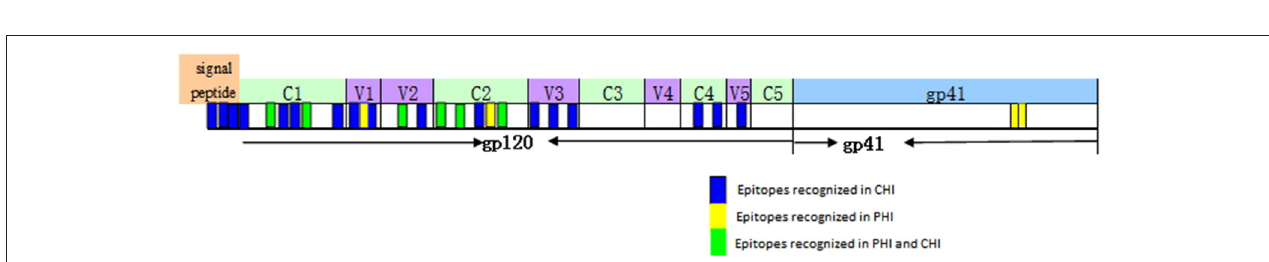
FIGURE 4 | Dynamic changes of the ADCC responses to HIV infection over time . (A) Rates of positive ADCC responses at different times during HIV infection (1–3 Months: n = 34; 3–6 Months: n = 15; 6–12 Months: n = 6; 1–2 Years: n = 7; 2–3 Years: n = 6; > 3 Years: n = 4). (B) Percentages of IFN- γ + NK cells, indicating an ADCC response, at different times during HIV infection (1–3 Months: n = 34; 3–6 Months: n = 15; 6–12 Months: n = 6; 1–2 Years: n = 7; 2–3 Years: n = 6; > 3 Years: n = 4).